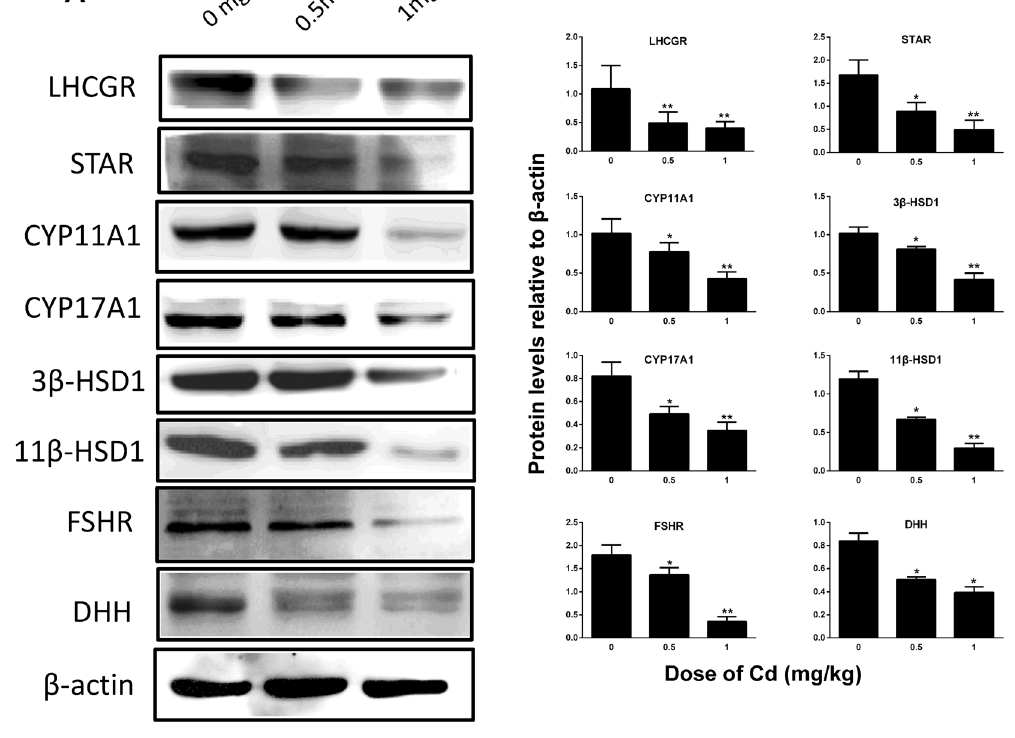
Figure 3. Protein levels of Leydig and Sertoli cells. Leydig cell proteins: ( A ) Western blot band. ( B ) Quantification of protein levels. Mean ± SE, n = 5. * P < 0.05, ** P < 0.01 indicate significant differences when compared to control (0